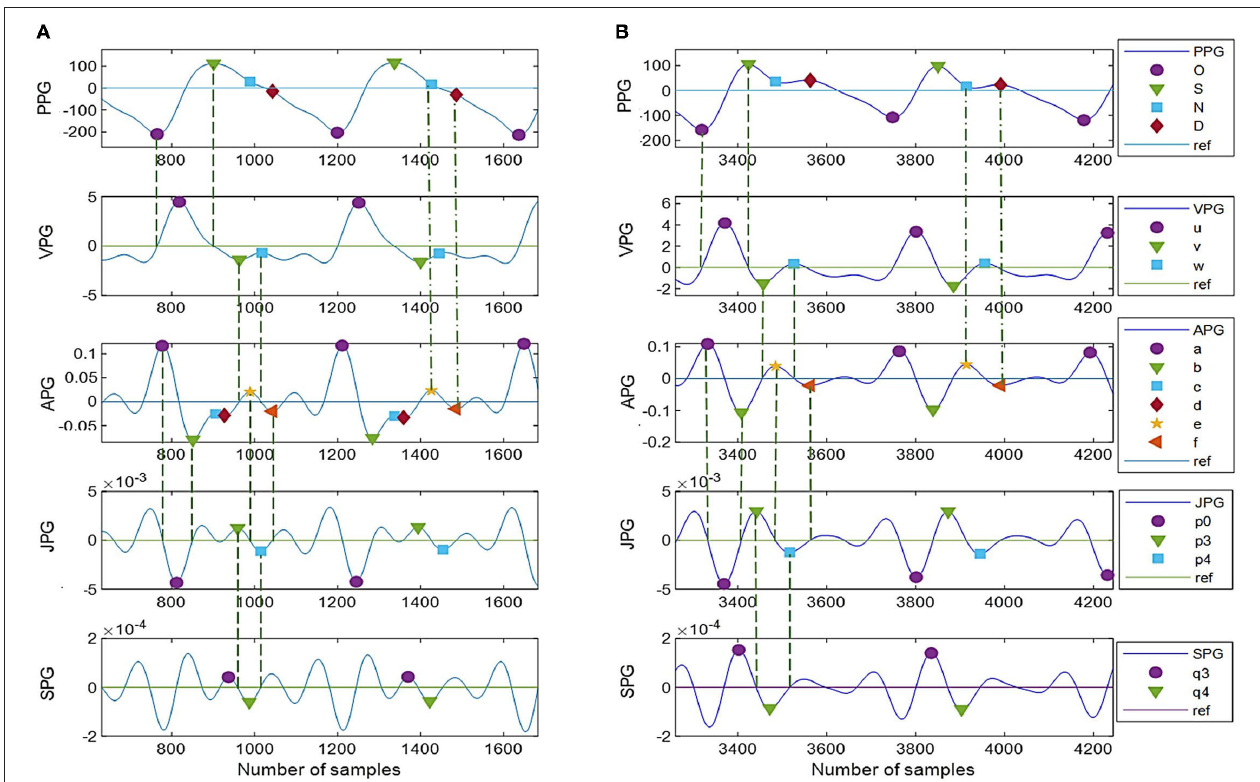
FIGURE 6 | (A,B) Peak detection using DMM with twelve derivative markers. Type I: unclear N-peak and D-peak but with more inflection points on derivative waveforms, Type II: clear N-peak and D-peak but less information on derivative